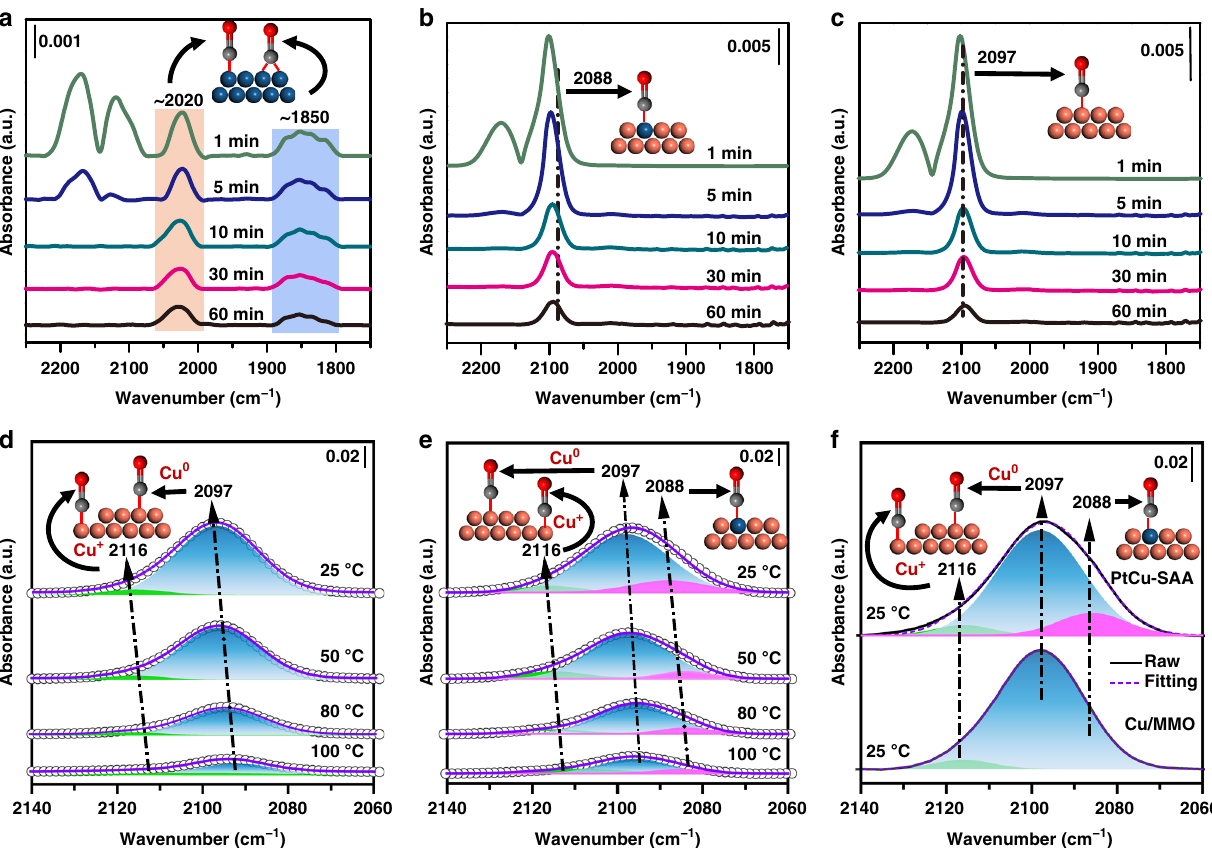
Fig. 3 In situ infrared spectroscopy studies on PtCu – SAA surface. In situ CO-DRIFTS spectra of a Pt/MMO, b PtCu – SAA, and c Cu/MMO purging with helium as a function of time; the enlarged and Gaussian fi tting spectra with a fi xed peak position and FWHM of d Cu/MMO and e PtCu – SAA as a function of temperature (the black hollow circle: experimental data; the violet solid line: fi tting curve); f in situ CO-DRIFTS spectra of Cu/MMO and PtCu – SAA at 25 °C (the black solid line: experimental data; the violet dotted line: fi tting curve). Cu, orange, Pt, blue, C, gray, O,